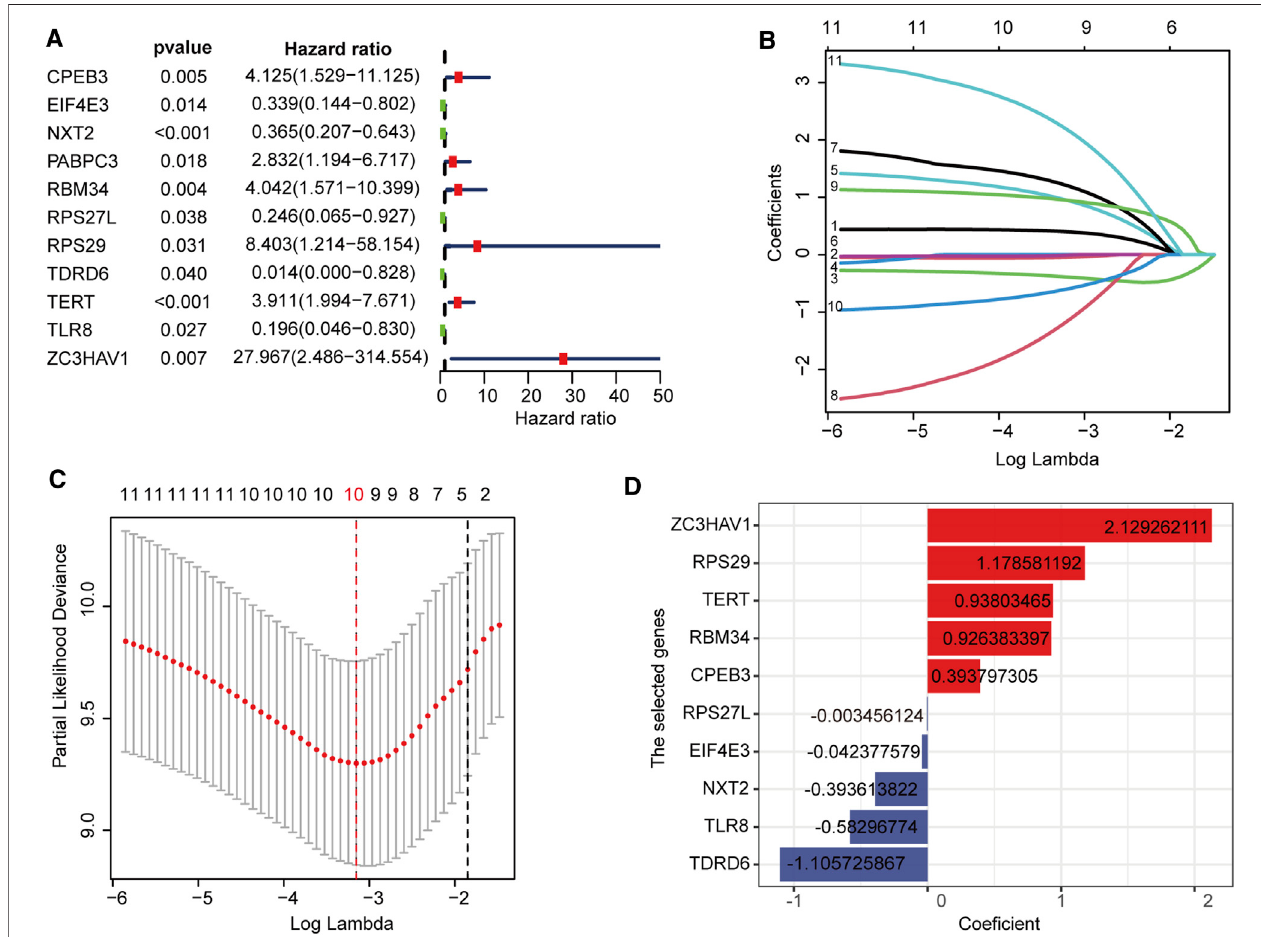
FIGURE2 | Construction ofthe RBPsprognostic signature (A) Univariate Coxregression revealed 11RBPsassociatedwith the prognosis ofosteosarcoma (B,C) LASSO Cox regression analysis screened out 10 best genes to build the prognostic signature (D) The coef fi cients of 10 prognostic-related RBPs.